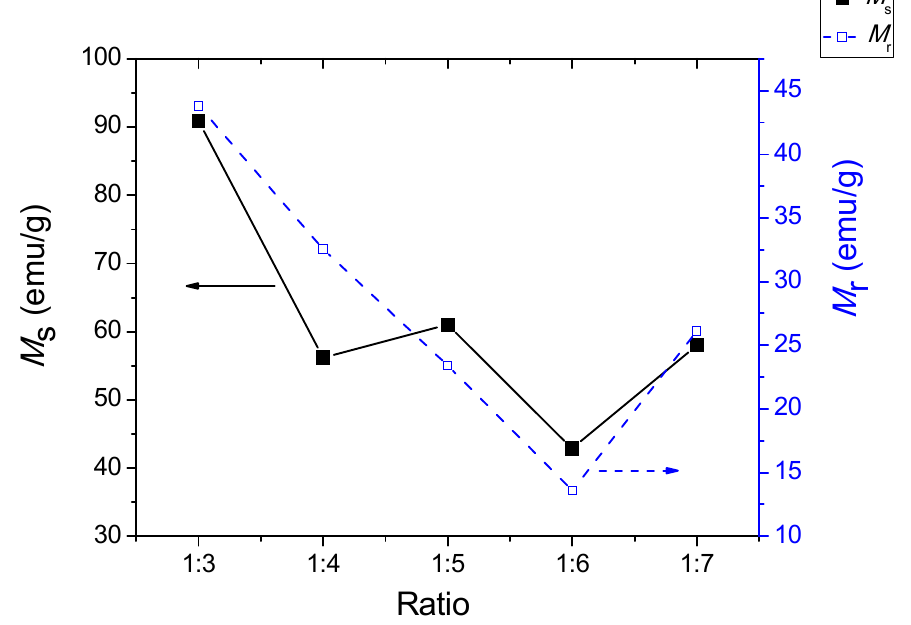
Figure 7. Variation of saturation magnetization, M s , and remnant, M r , of BaFe 12 O 19 at different ratios.